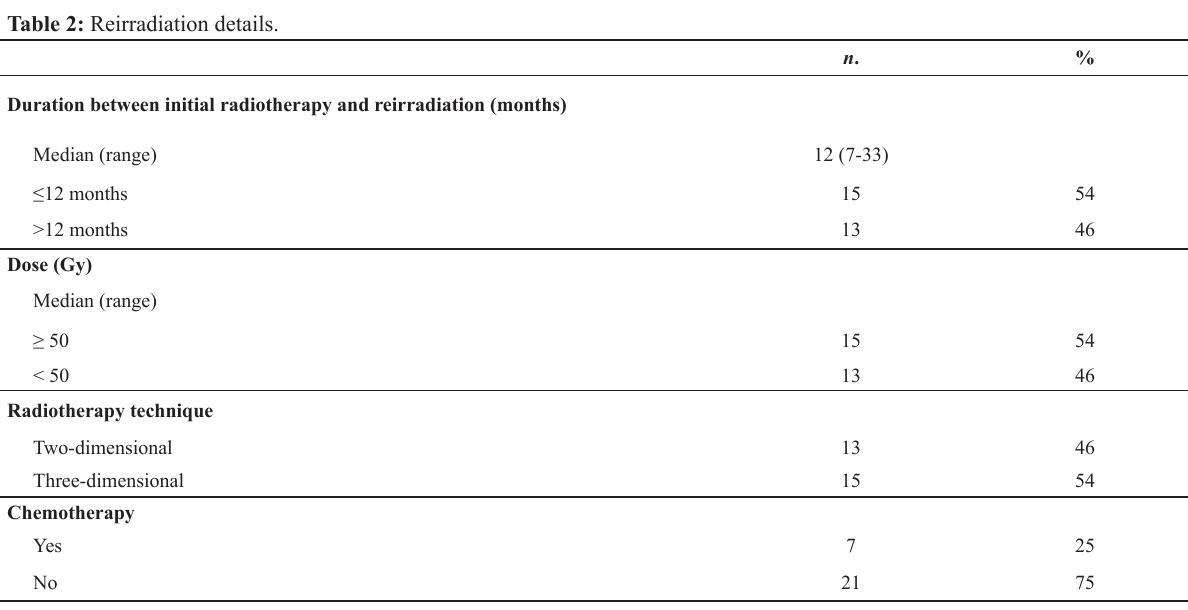
Table 2: Reirradiation details.